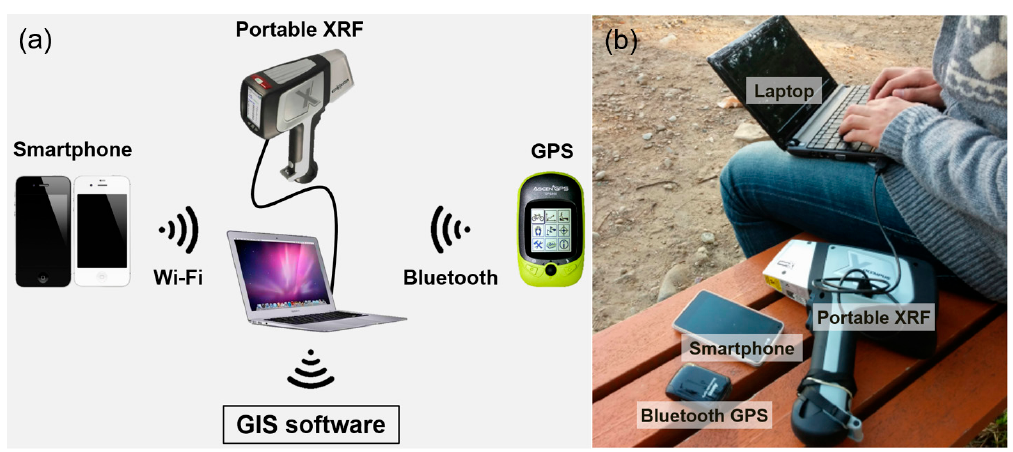
Figure 4. Near real-time data transmission system. ( a ) Conceptual diagram; ( b ) Photo of instruments.